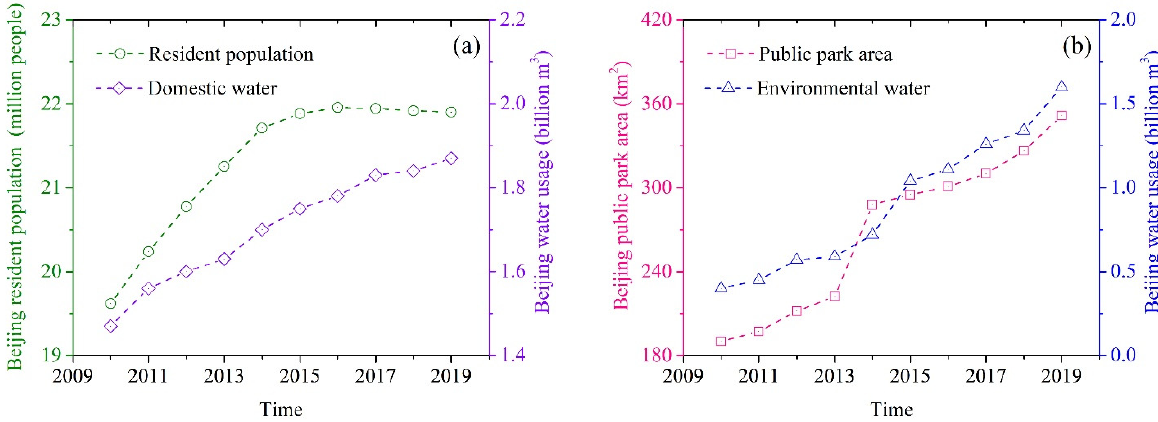
Figure 7. ( a ) The relation between resident population and domestic water. ( b ) The relation be- tween public park area and environmental water.